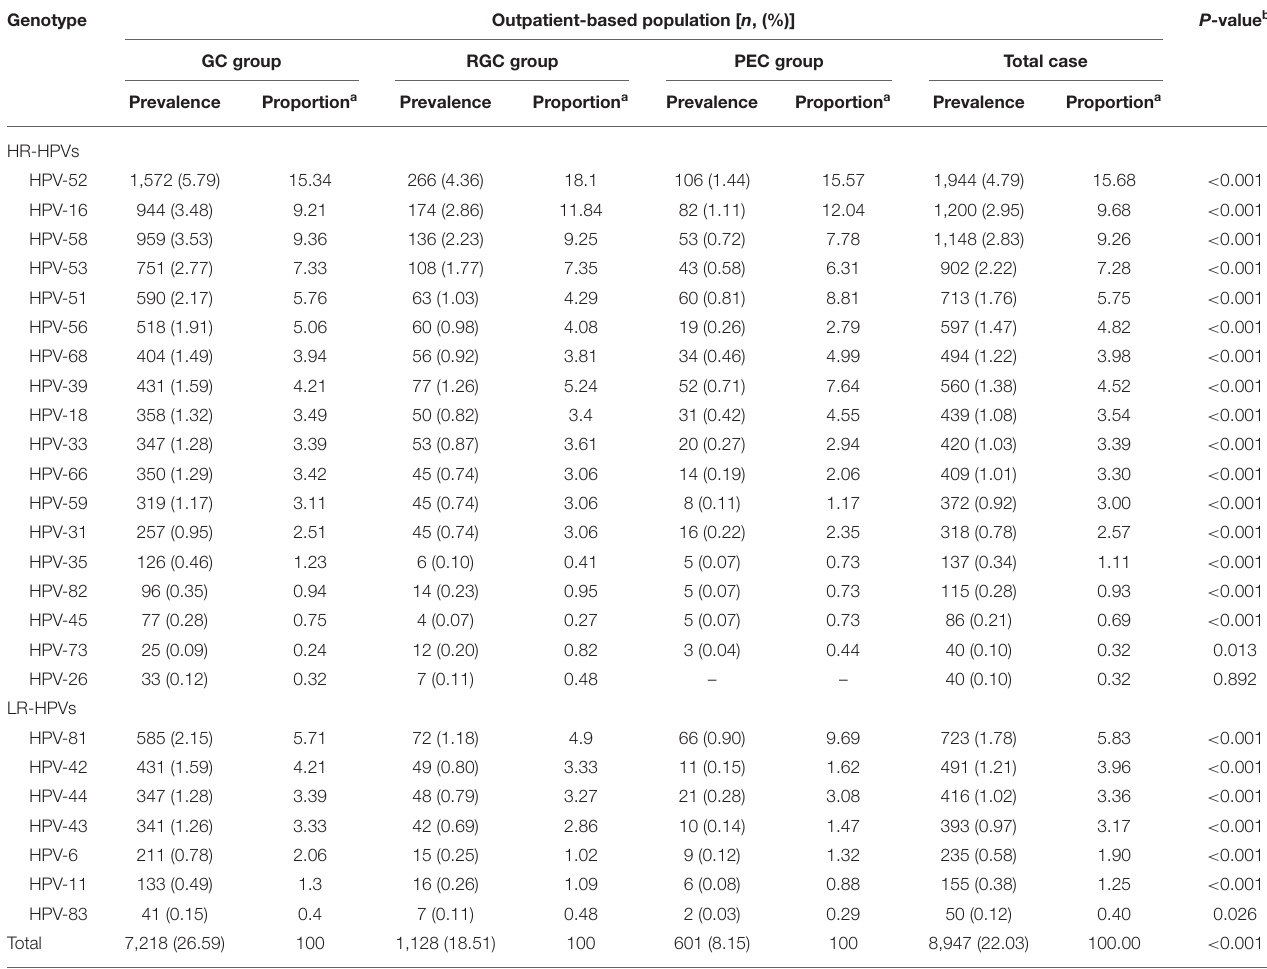
TABLE 2 | Prevalence of HPV genotypes in HPV-positive cases. Genotype Outpatient-based population [ n , (%)] P -value b